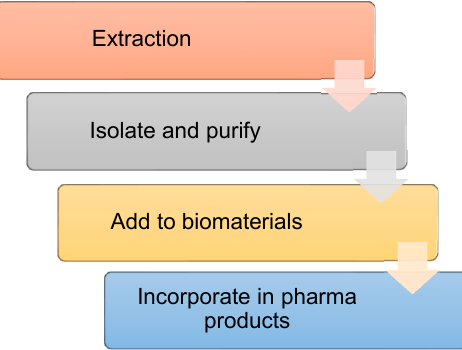
Figure 4. Operations for obtaining and incorporating secondary metabolites in dermatological products. During the extraction, it is necessary to use green and innocuous solvents to extract large amounts of the compounds of interest. During its isolation and purification, column and thin-layer chromatography are recommended, as well as spectroscopic tools, to elucidate and monitor the compound of interest. Once the metabolite is isolated and purified, it is necessary to use biomaterials that protect it and, at the same time, be innocuous and biodegradable. It is worth mentioning that before their incorporation into pharmaceutical products, it is necessary to evaluate the biological, functional, and in vitro and in vivo tests. It is worth mentioning that the incorporation into the final product must be during operations that safeguard its bioactivity and